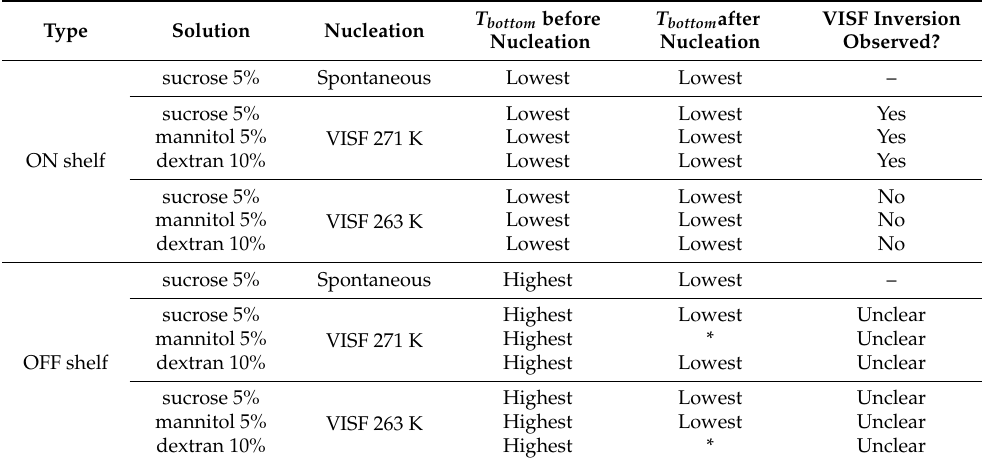
T bottom before T bottom after VISF Inversion Nucleation Nucleation Observed?